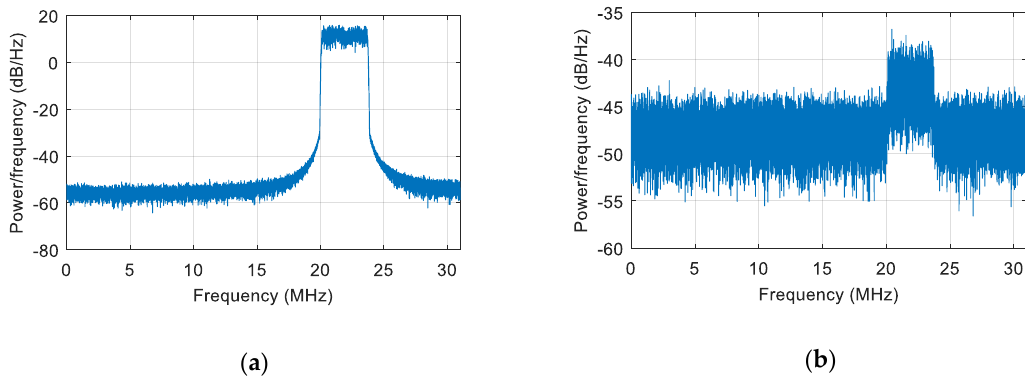
Figure 14. The power spectral density of the signal in the higher dynamic scene. ( a ) The power spectral density of the signal before interference suppression; ( b ) the power spectral density of the signal after interference suppression.